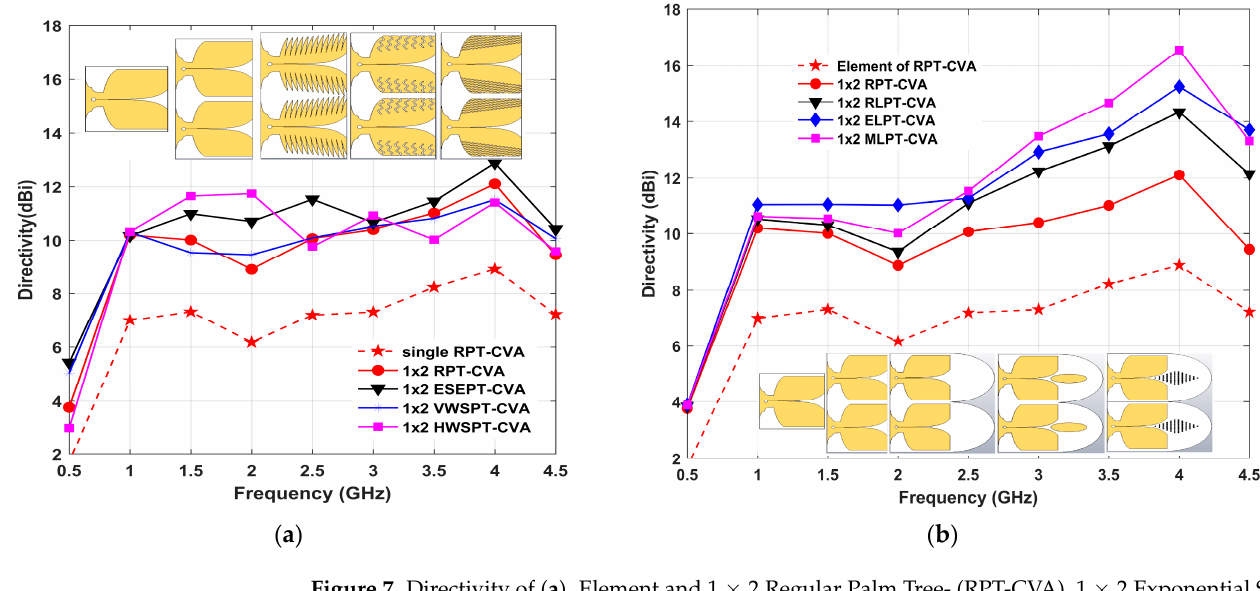
Figure 7. Directivity of ( a ). Element and 1 × 2 Regular Palm Tree ‐ (RPT–CVA), 1 × 2 Exponential Slot Edge Palm Tree (ESE–CVA), 1 × 2 Vertical Wave Structure Palm Tree (VWPT–CVA), 1 × 2 Horizontale Wave Structure Palm Tree (HWPT–CVA), and ( b ). Element and 1 × 2 Regular Palm Tree ‐ Coplanar Vivaldi Antena (RPT–CVA), 1 × 2 Regular Lens Palm Tree (RLPT–CVA), 1 × 2 Elips Lens Palm Tree (ELPT–CVA), And 1 × 2 Metamaterial Lens Palm Tree (MLPT–CVA) .